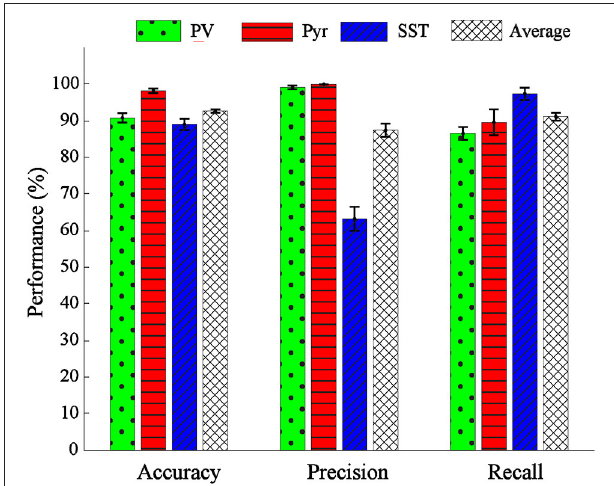
FIGURE 6 | Performance evaluation in terms of accuracy, precision, and recall. The performance of classification was shown for single classes of PV (green bar), Pyr (red bar), and SST (blue bar) and also their overall mean (black dashed